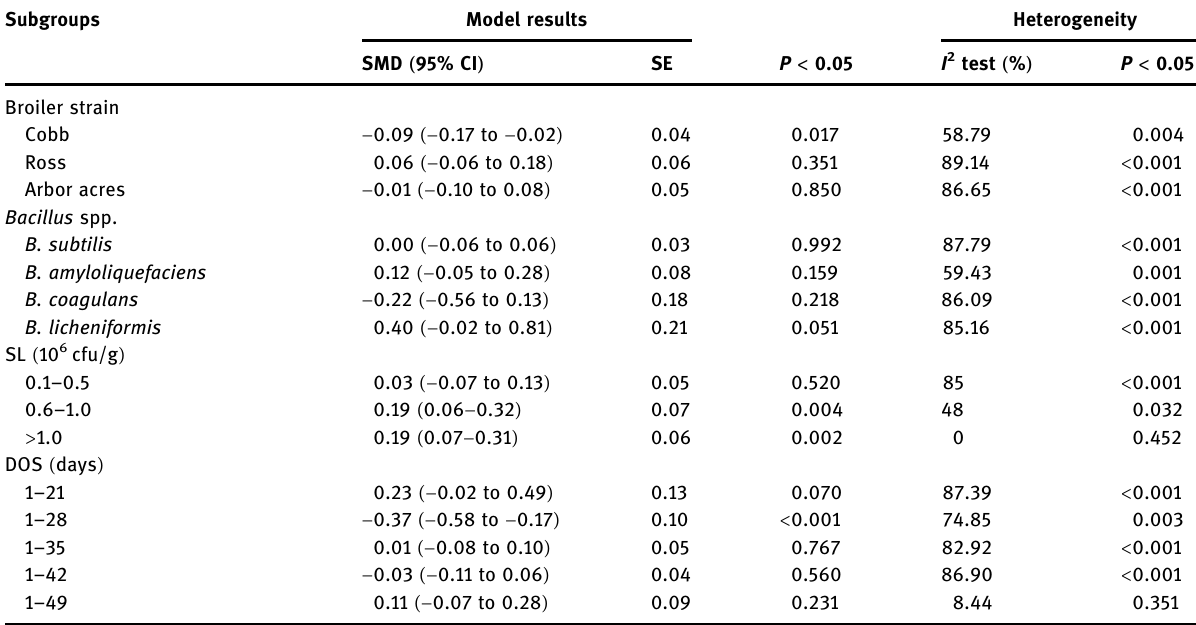
Table 2: Subgroup analysis of the e ff ect of Bacillus probiotics on feed intake of broiler chickens Subgroups